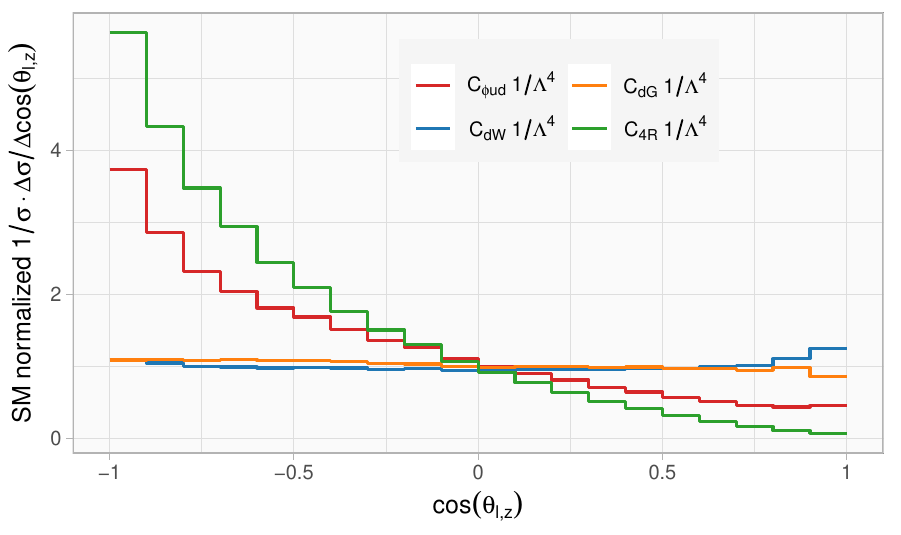
Figure 25. To itself and to the SM normalized SMEFT contributions to the cos (cid:18) l;z distribution at NLO in QCD . Results are presented for Q 33 operator Q 4 R .